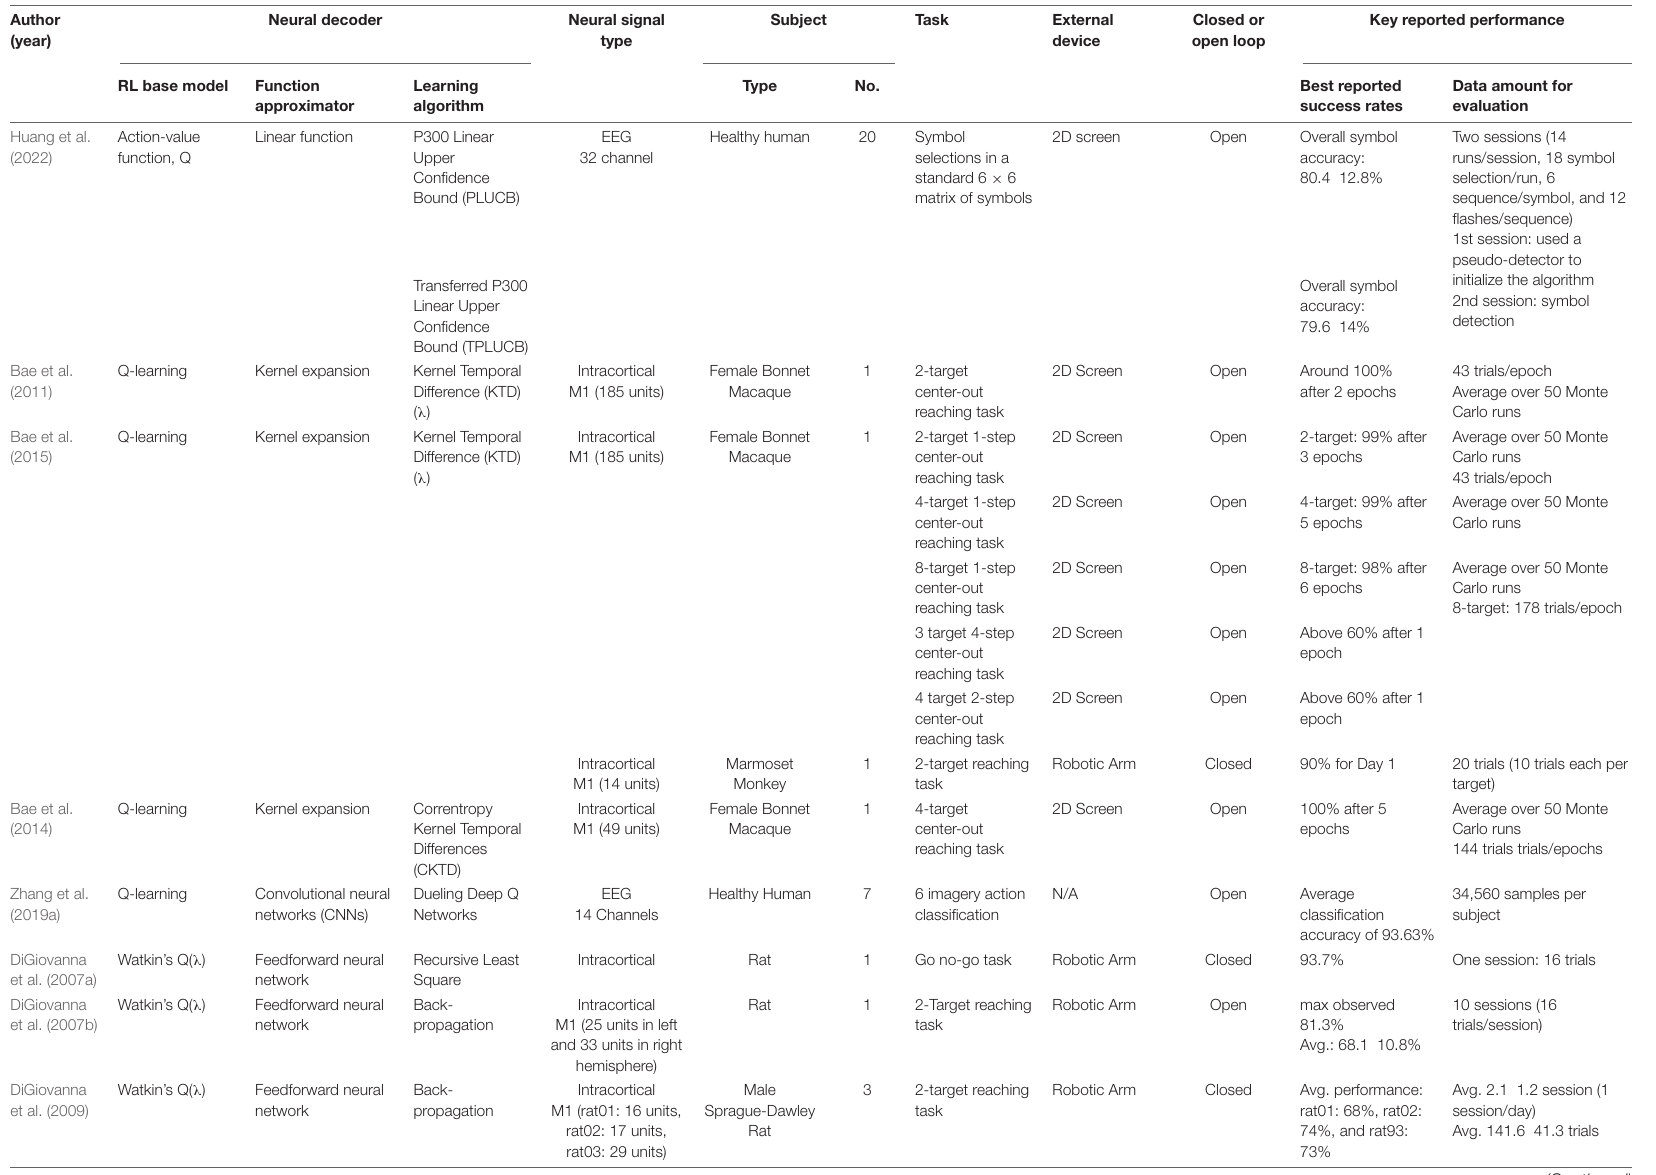
TABLE 1 | A summary of reviewed neural decoders in RLBMIs. Author